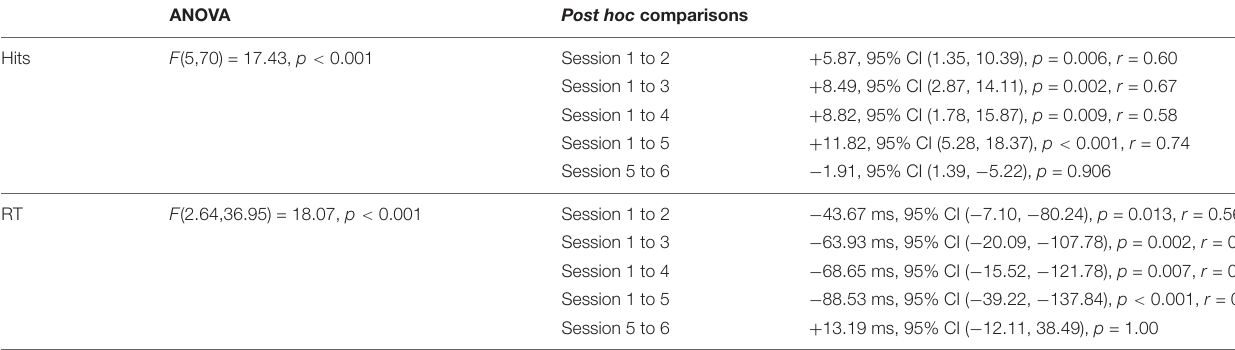
TABLE 4 | ANOVAs and post hoc comparisons for both hits and RT data from Study 2. ANOVA Post hoc comparisons